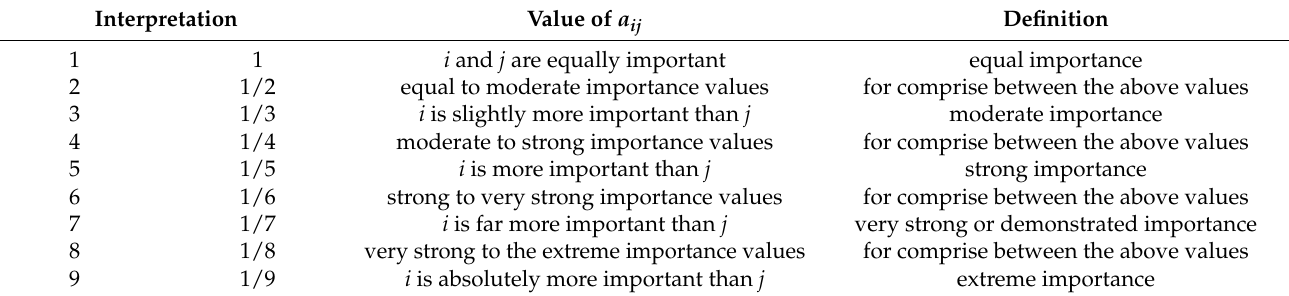
Table 3. Scale of relative importance (after Saaty